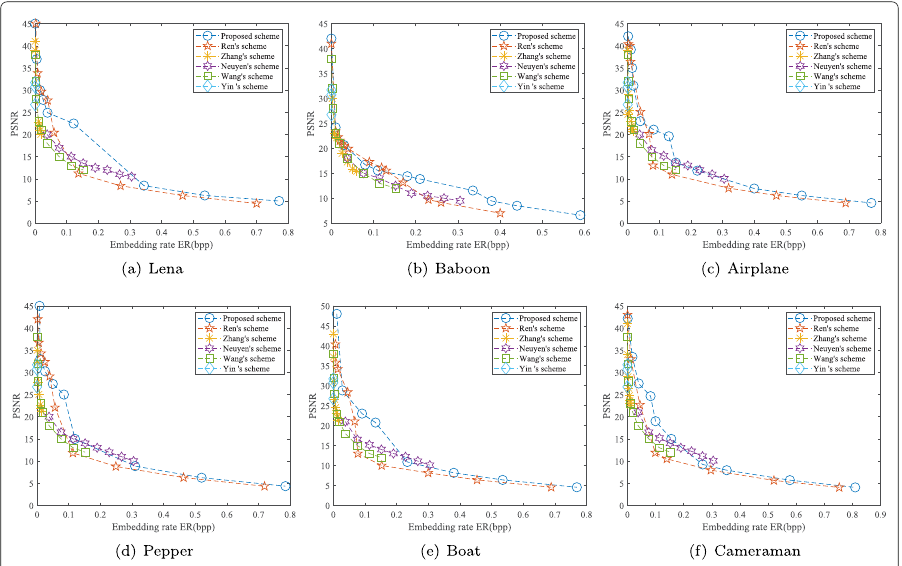
Fig. 12 Overall performance comparison between PSNR and embedding rate for six different RDH schemes in binary